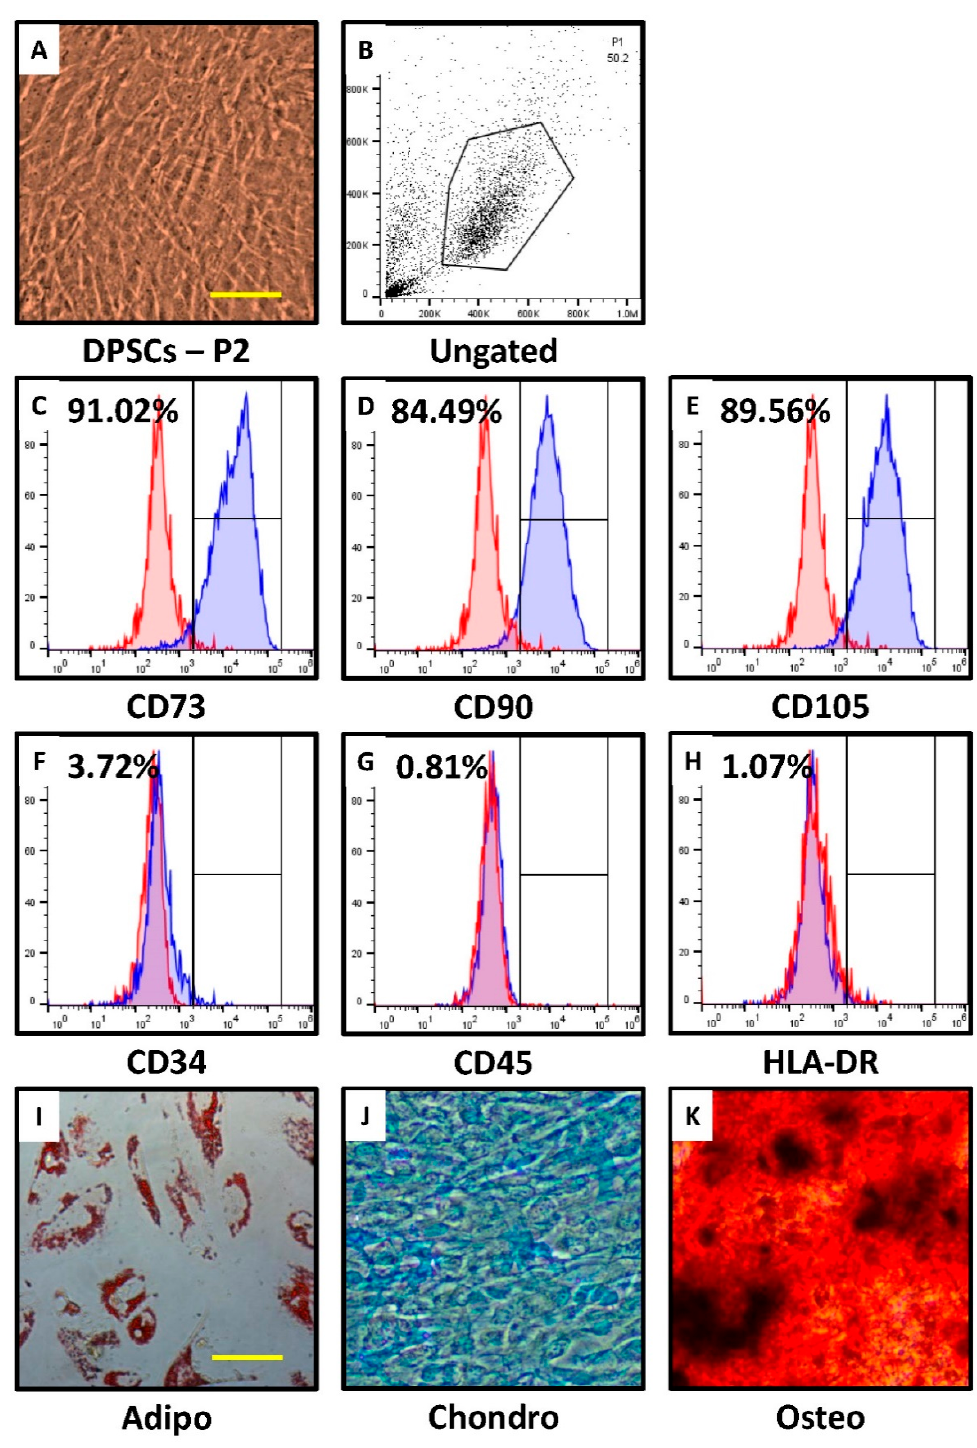
Figure 1. Characterization of DPSCs for mesenchymal stem cell properties. ( A ) Photomicrograph of DPSCs at passage 2. Scale bar = 100 µm, ( B – H ) DPSCs were checked for MSC-specific positive markers CD73, CD90, and CD105; and MSC-specific negative markers CD34, CD45, and HLA-DR. ( I – K ) Differentiation of GMSCs into adipocytes, osteoblasts, and chondrocytes. Scale bar = 100 µm.